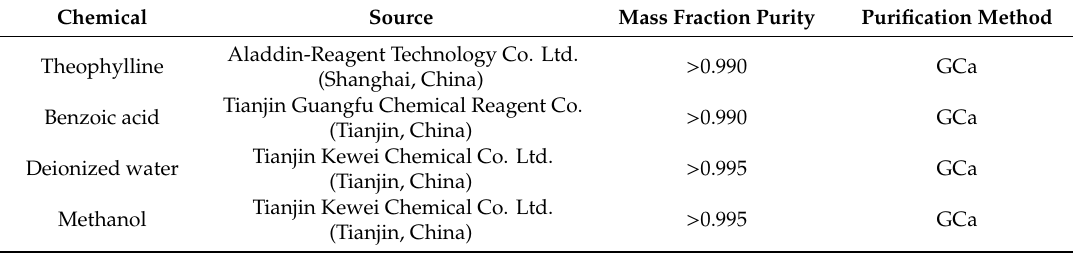
Table 1. Description of materials used in this